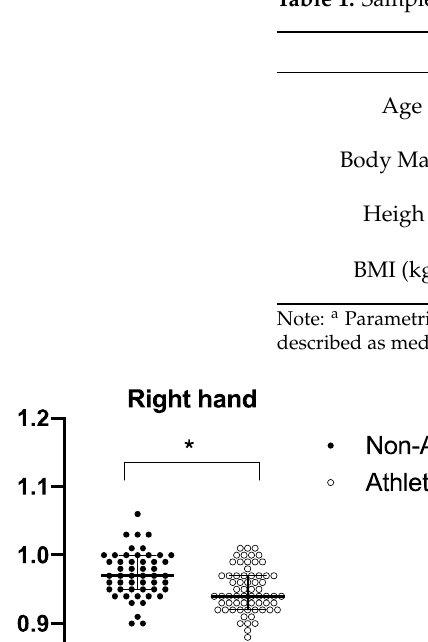
Table 1. Sample characterization and descriptive statistics.